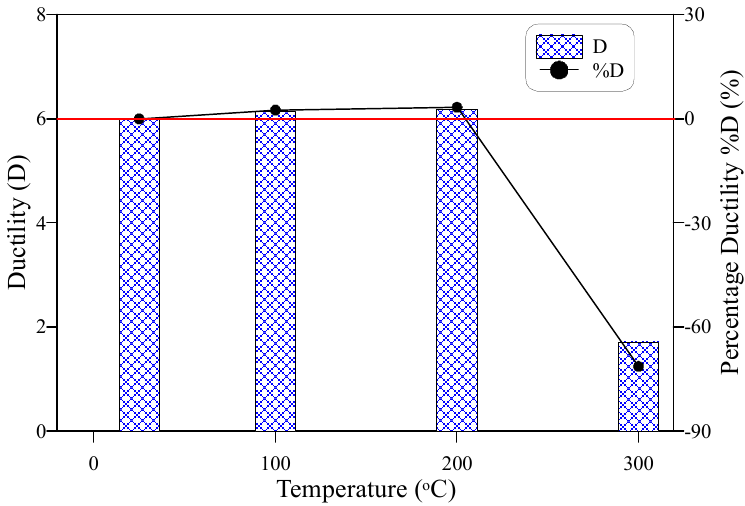
Figure 12. Impact ductility-temperature behavior.